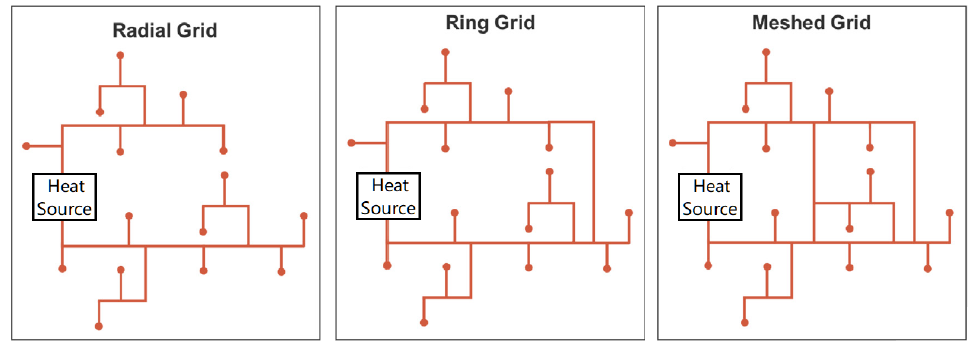
Figure 9. Grid topology for DH systems, adapted with permission from [139]. 2022, Justus von